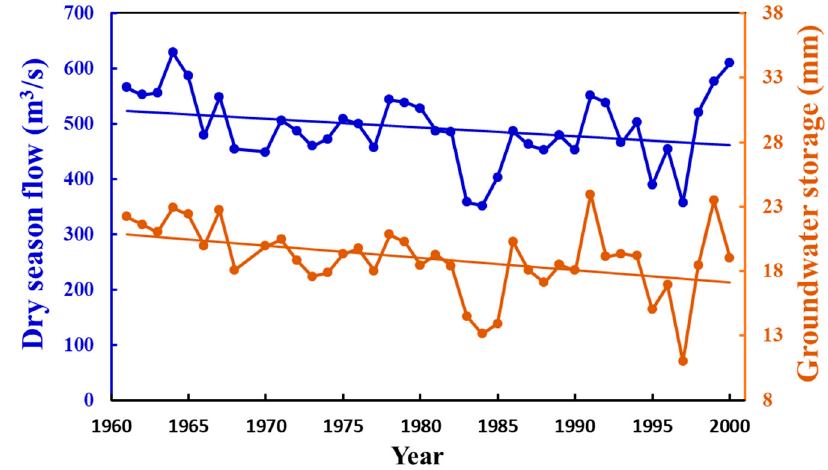
Figure 7. Annual mean flow of dry season (December to April, blue line) and estimated groundwater storage (orange line) with their trend lines.